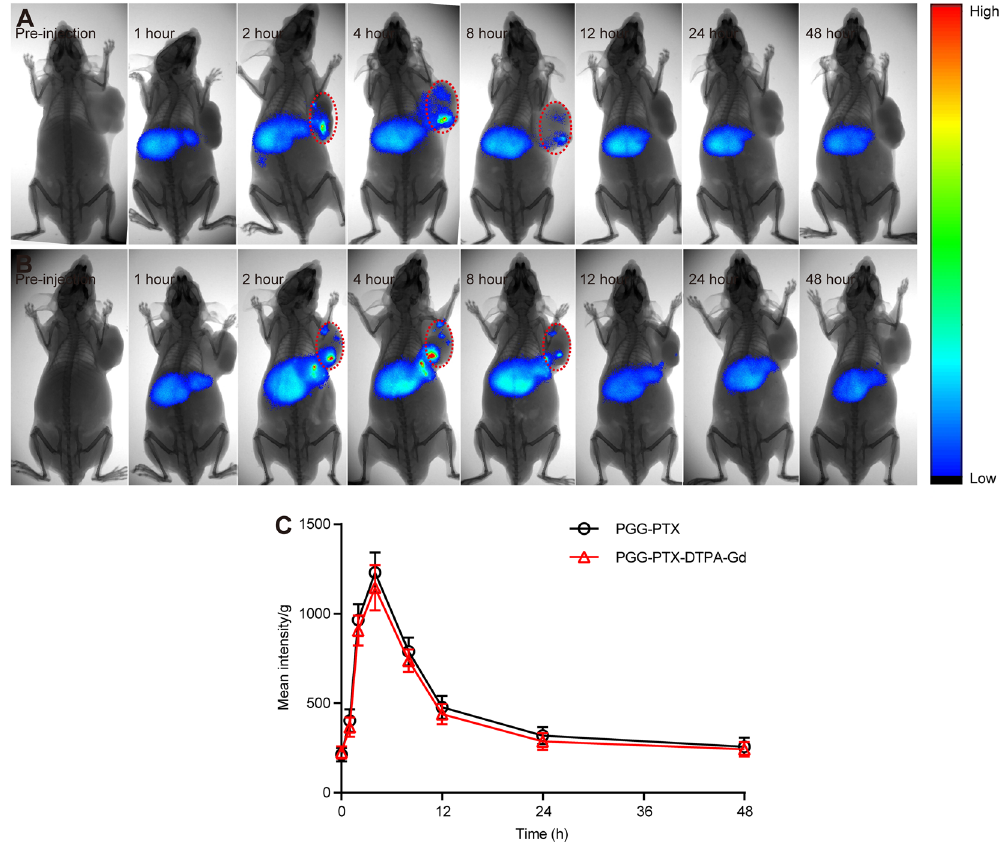
Figure 4. In vivo fluorescent imaging of NCI-H460-bearing nude mice (n = 3) after the intravenous injection of PGG-PTX/DiR NPs ( A ) and PGG-PTX-DTPA-Gd/DiR NPs ( B ). Representative in vivo fluorescent images of NCI-H460-bearing nude mice following i.v. administration of PGG-PTX-DTPA-Gd/DiR NPs at different time points (pre-injection, 1, 2, 4, 8, 12, 24, 48 hour). Color bar on the right side indicates the signal efficiency of the fluorescence emission. ( C ) Pharmacokinetic profile of DiR in the tumor tissue of animal model after i.v. injection of PGG-PTX-DTPA-Gd/DiR NPs based on the semi-quantitative ROI analysis of in vivo fluorescent images. The conjugation of Gd-DTPA to PGG-PTX did not affect the distribution of PGG-PTX NPs in nude